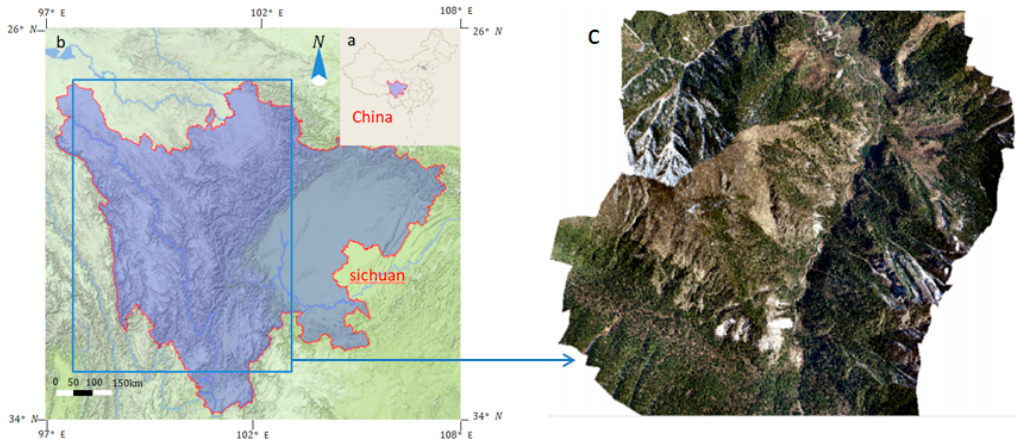
Figure 4. Location and remote sensing imagery of the study area. ( a ) Sichuan’s location in China. ( b ) The latitude and longitude extent of the study area. ( c ) Remote sensing images of the study area.